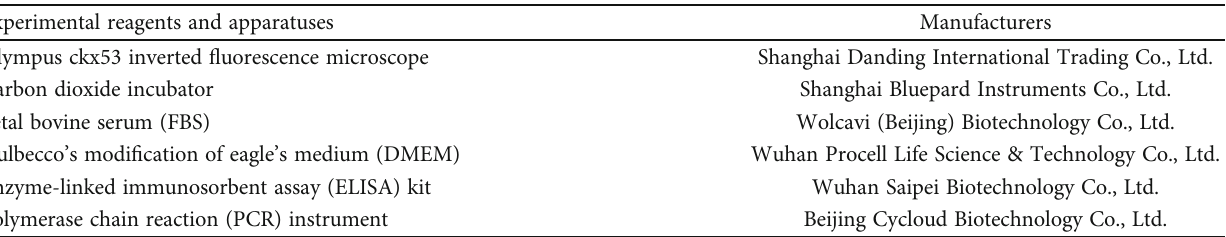
Table 2: Experimental reagents and